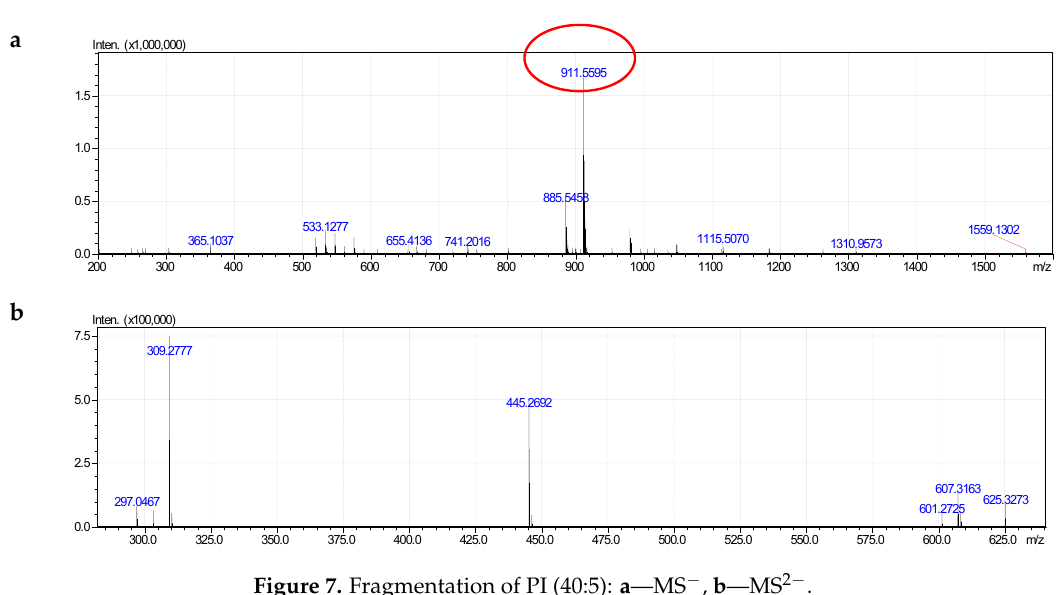
Figure 6. Fragmentation of PS (40:5): a —MS − , b —MS 2 − .